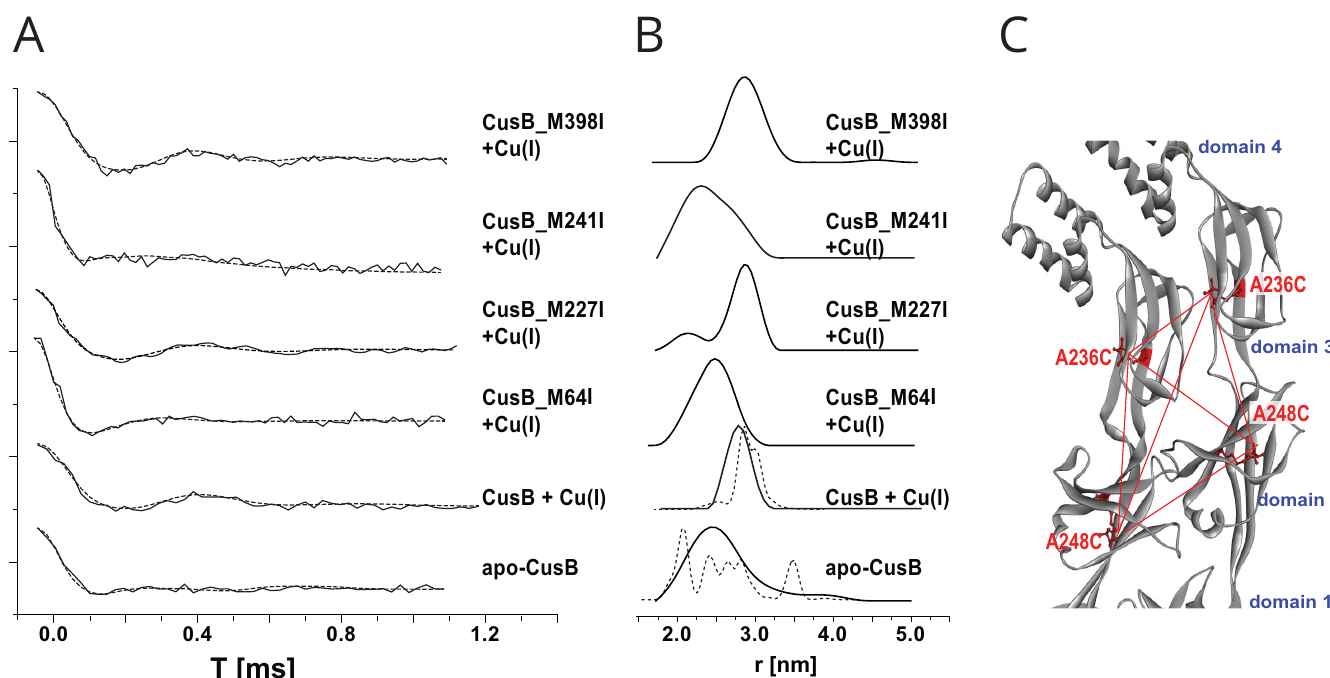
Fig 3. Distance distribution measurements (DEER) on CusB mutants. A. DEER time domain signals (solid lines) and fits (dashed lines) based on Tikhonov regularization for apo-CusB and CusB + Cu(I) (at a Cu(I):CusB ratio of 3:1) and various CusB + Cu(I) mutants spin labeled at the A236C and A248C positions. B. Corresponding distance distribution functions. The dashed lines represent calculated distribution functions obtained for the apo-CusB and CusB + Cu(I) structure models. C. The positions of the spin labels in WT-CusB (A236C,A248C). The red dotted lines denote the six distances targeted here under the broad distance